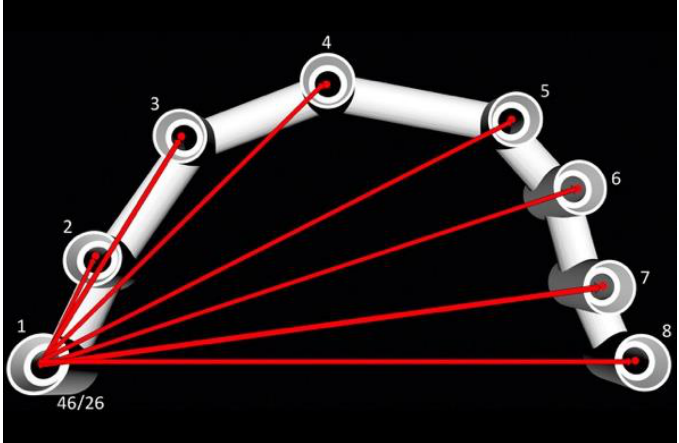
Figure 6. Representation of the Euclidean distances from abutments 1 to 8.